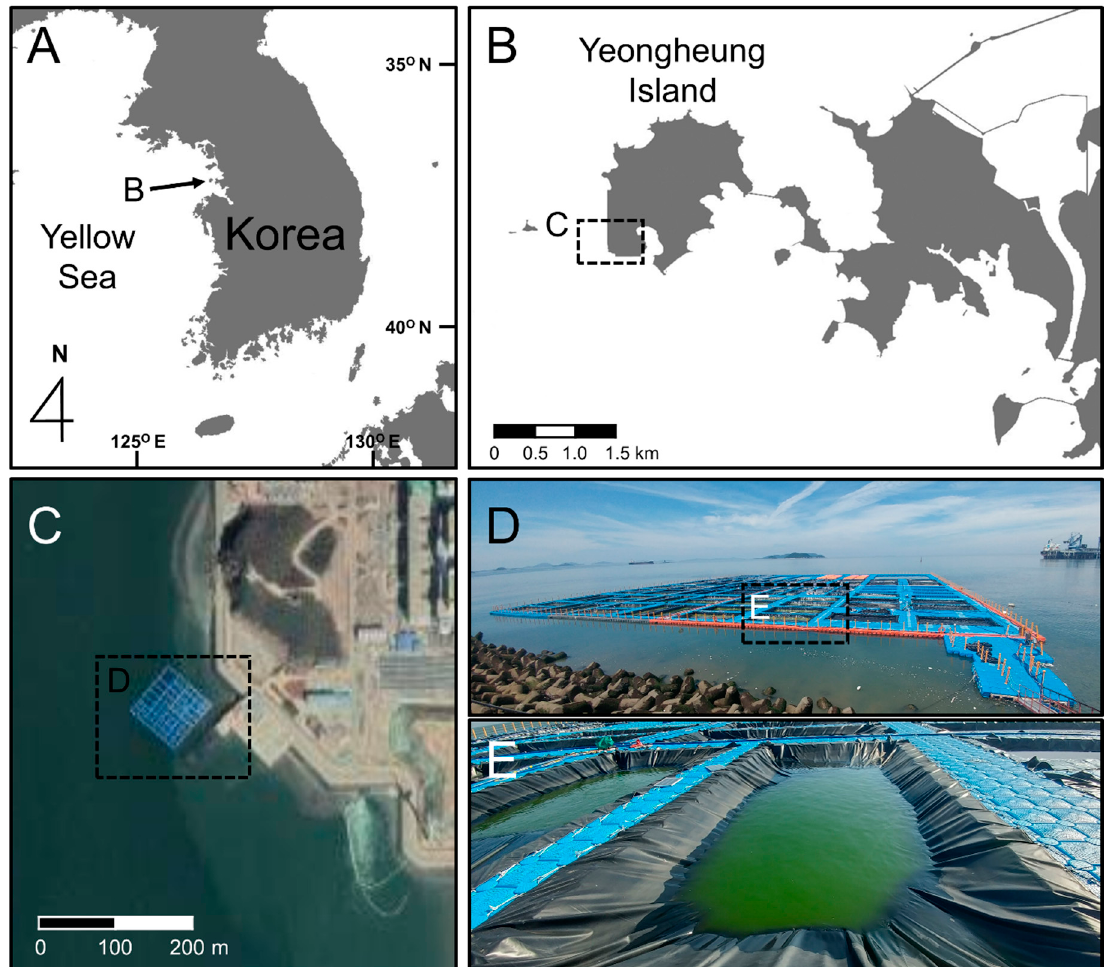
Figure 1. National ( A ) and regional ( B ) locations where the “marine culturing field” is located, viewed on a Google Map ( C ) (http://map.google.com; 37°14 ′ 00.3” north (N) 126°25 ′ 50.6” east (E)). The view of the operating marine culturing field ( D ), and the installed cultivation pond made using semi- permeable membrane ( E ).